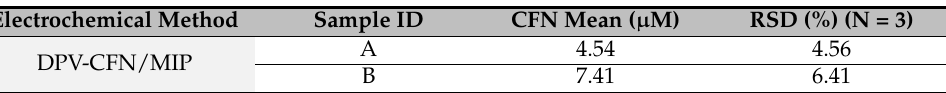
Table 4. Values obtained from the DPV CFN-MIP analysis of two specimens obtained from the in vitro metabolism of coumaphos to produce chlorferron.